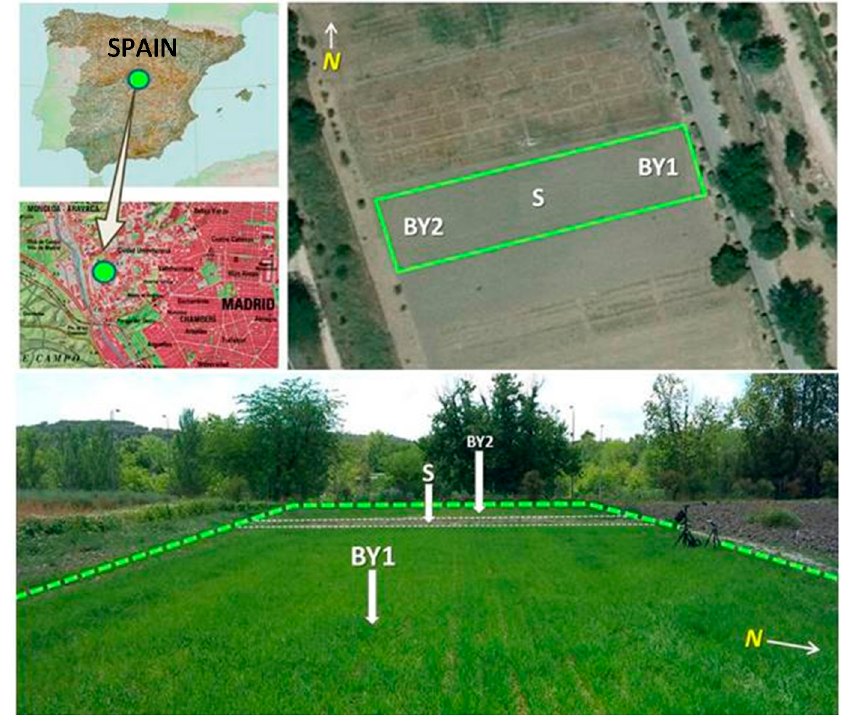
Figure 1. Experimental area and plots location (maps and orthoimage from IGN, www.ign.es/ign_iberpix/) and overview picture (13 May 2013).